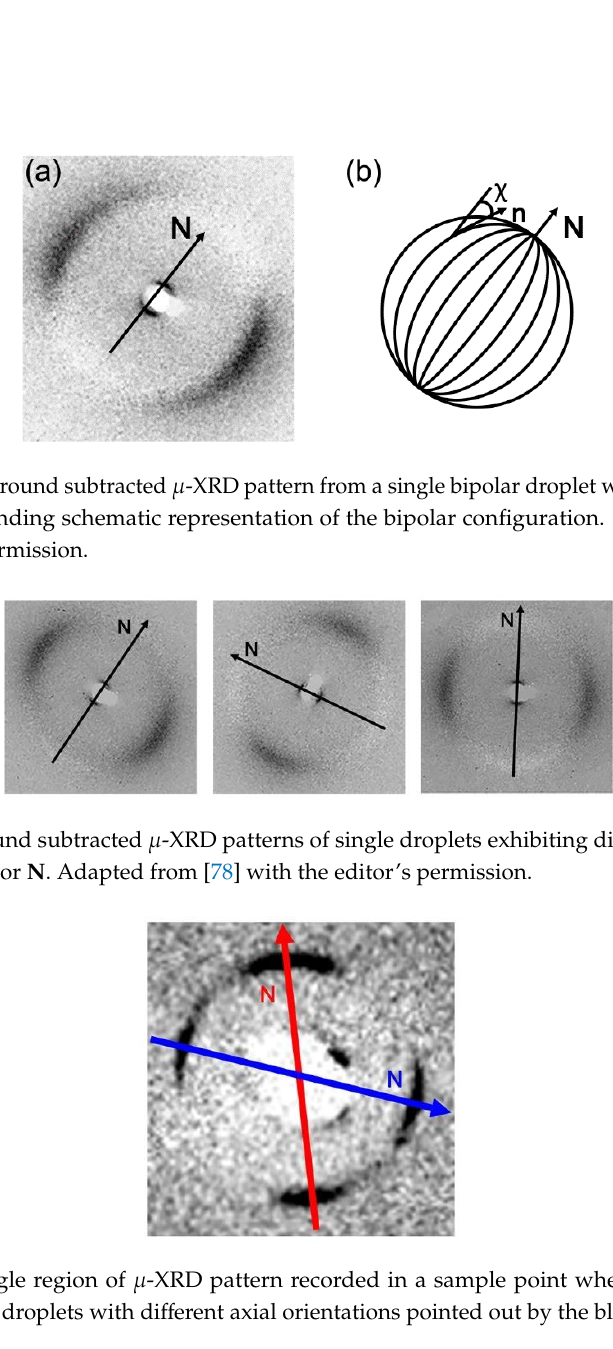
Figure 24. Low-angle region of μ -XRD pattern recorded in a sample point where the X-ray beam crosses two distinct droplets with different axial orientations pointed out by the blue and red versors.